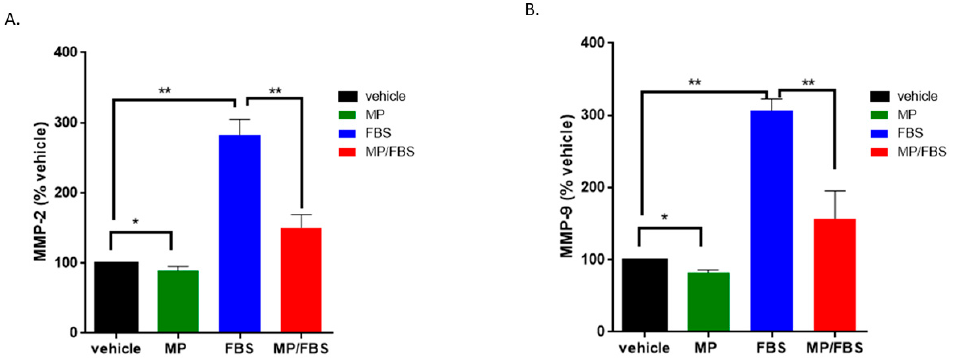
Figure 6. MP inhibits basal and FBS-induced MMP-2 and MMP-9 secretion . Cells were grown in starvation or complete medium, in presence or absence MP (100 µM). Levels of secreted MMP-2 ( A ) and MMP-9 ( B ) were evaluated by ELISA. Data represented are mean ± SEM of % MMP level in the corresponding vehicle-treated well. (* p < 0.05, ** p < 0.01). One-way ANOVA followed by Tukey’s test was performed.